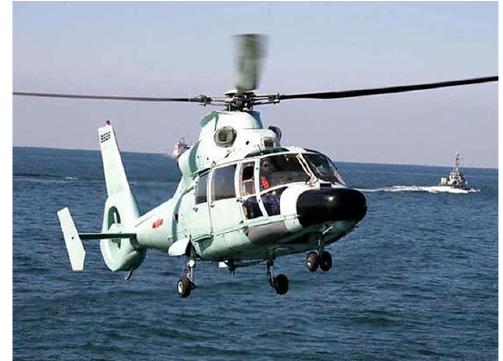
Figure 9. Z ‐ 9 helicopter prototype. Figure 9. Z-9 helicopter Table 2. Flight performance of prototype and design goal.